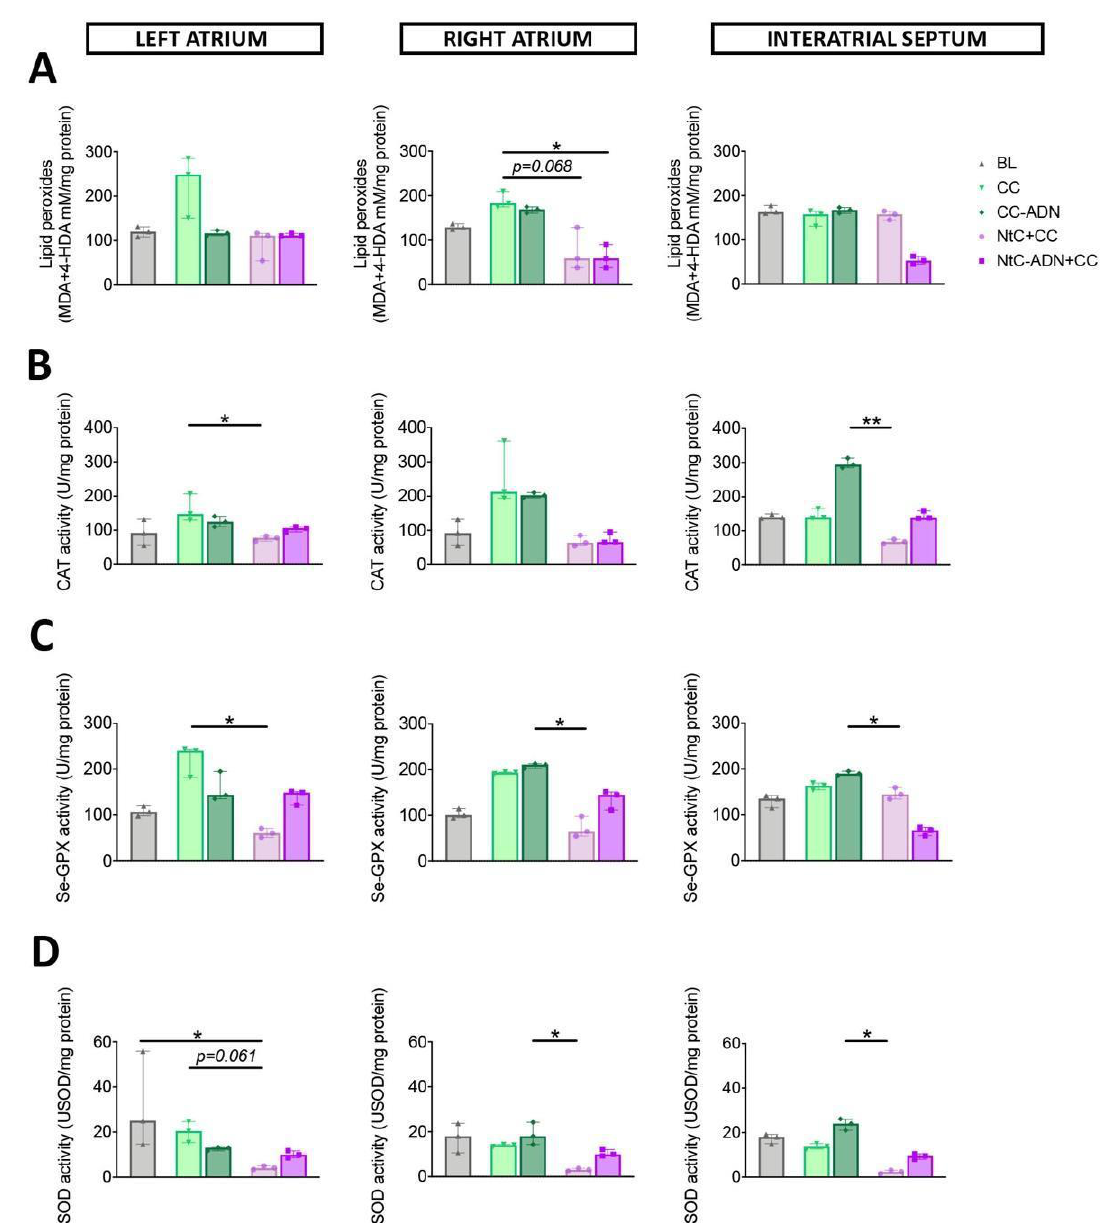
Figure 2. Oxidative damage is prevented when atrial tissue is protected with NtC + CC. Myocardial oxidative stress was quantified as ( A ) Myocardial lipid peroxidation; ( B ) Myocardial catalase activity; ( C ) Myocardial selenium-dependent glutathione peroxidase activity; ( D ) Myocardial SOD cytosolic activity. Values are shown as median ± range, n = 3. Note * p < 0.05, ** p < 0.01. BL: baseline; CC: cardioplegia; CC-ADN: cardioplegia supplemented with adenosine; NtC + CC: 250 mL warm cardioplegia + 750 mL cold cardioplegia; NtC-ADN + CC: 250 mL warm cardioplegia supplemented with adenosine + 750 mL cold cardioplegia.